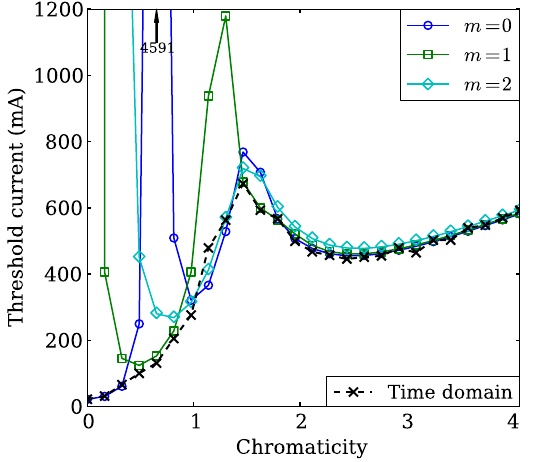
FIG. 21. Ratio of threshold currents predicted by time domain simulations of the flattened potential to those predicted by frequency domain calculations for a flattened bunch distribution with the same bunch